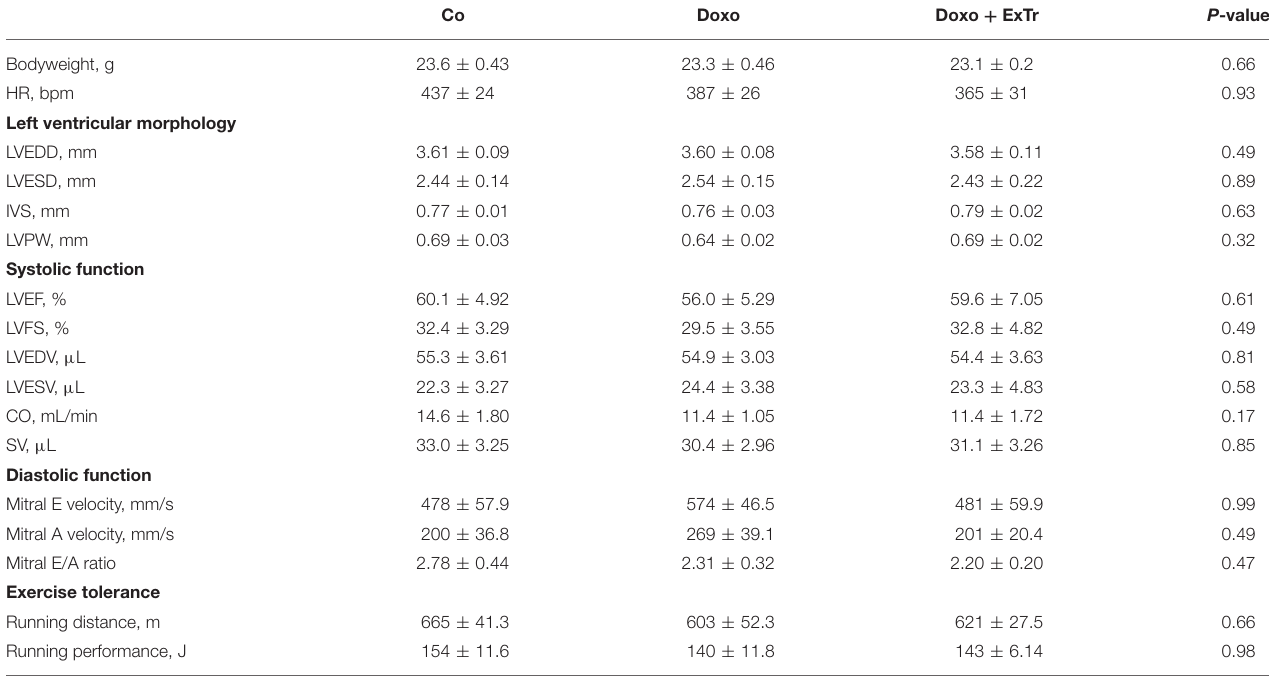
TABLE 1 | Physical characteristics, ventricular morphology and function, and effort tolerance at